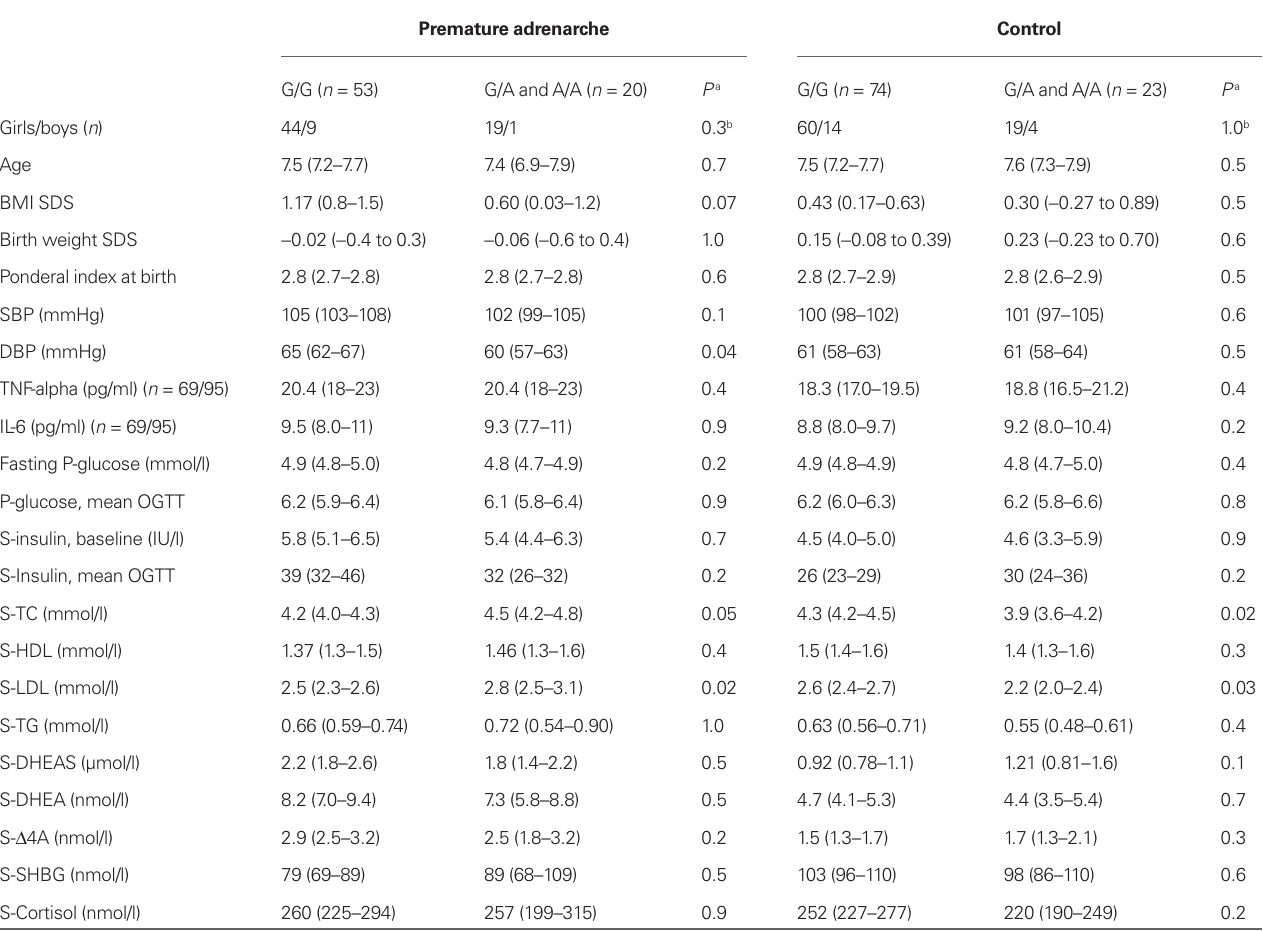
Table 3 | Clinical and biochemical characteristics according to the TNF- α -308 G > A genotype groups among the subjects with premature adrenarche and